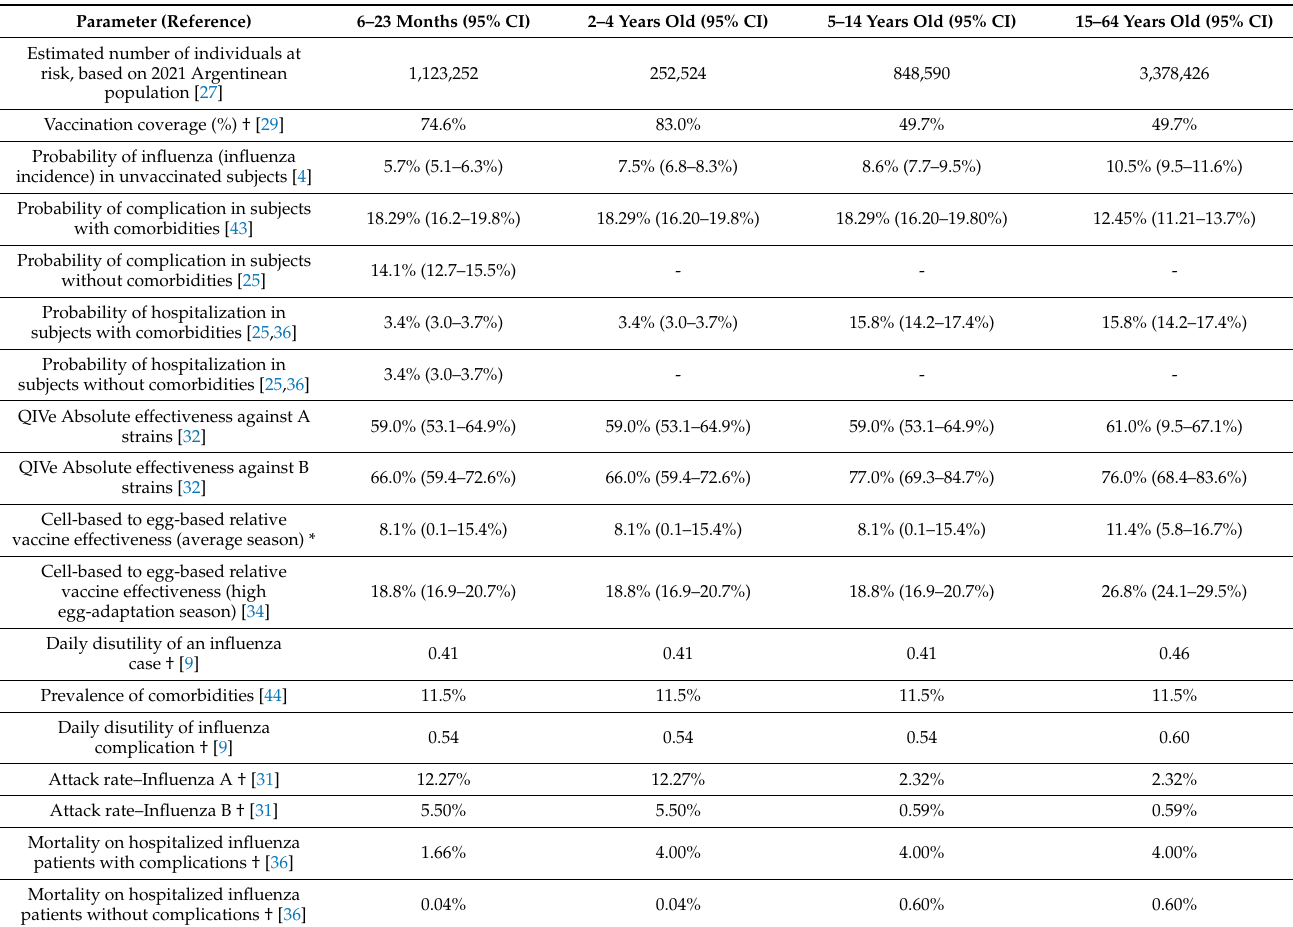
Table 1. Epidemiological